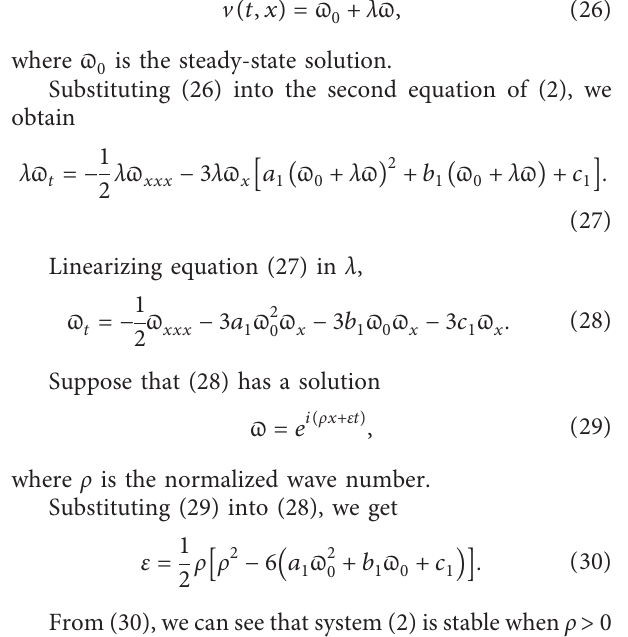
Figure 3: The kink solitary wave solution v (a) Perspective view of the wave. (b) The wave along x